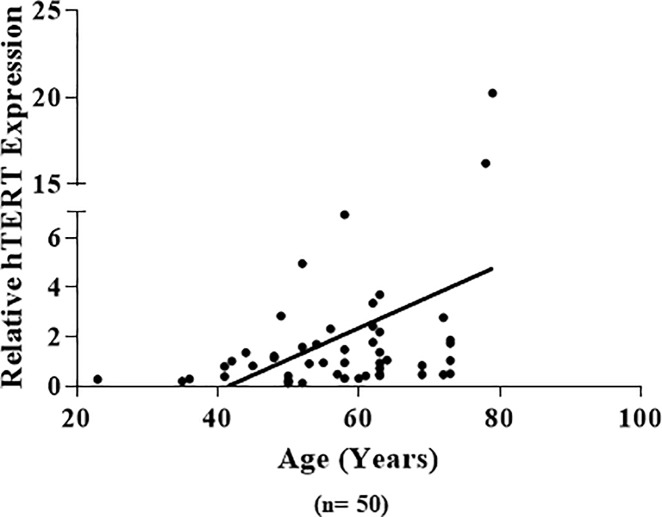
A correlative plot of relative hTERT expression and patient's age.Positive correlation is observed, Correlation coefficient = 0.411, p-value <0.01.